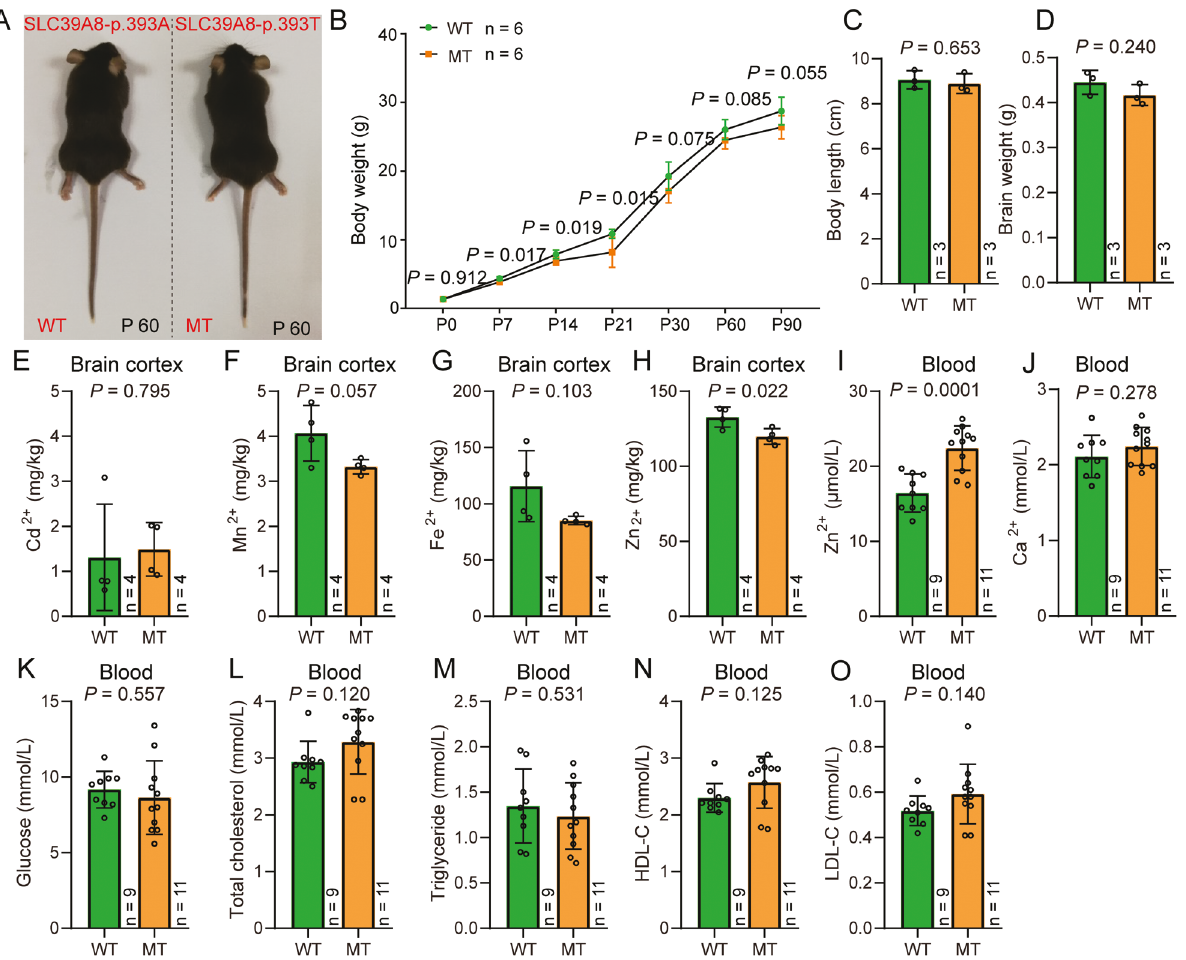
Fig. 2 Impact of SLC39A8-p.393T knock-in on global growth and ions concentration. A – C SLC39A8-p.393T knock-in did not affect body length and weight. D SLC39A8-p.393T knock-in did not affect brain weight. E – G SLC39A8-p.393T knock-in did not affect cadmium, manganese and iron concentration in brain tissues. H SLC39A8-p.393T knock-in resulted in down-regulation of zinc concentration in brain tissues. I SLC39A8-p.393T knock-in resulted in up-regulation of zinc concentration in blood. J – O SLC39A8-p.393T knock-in did not affect calcium concentration, glucose, cholesterol, triglyceride, HDL-C and LDL-C. Two-tailed Student ’ s t - test was used for statistical test. Data represent mean ± SD, n = 6 for ( B ), n = 3 for ( C and D ), n = 4 for ( E – H ), n (WT) = 9 and n (MT) = 11 for ( J – O